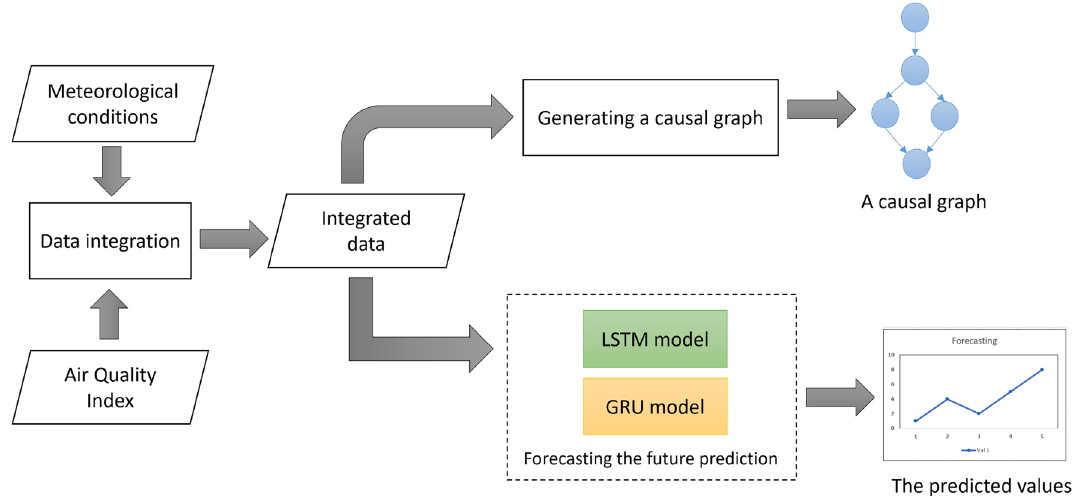
Figure 1. The proposed method of an integration analysis of air pollution and meteorological